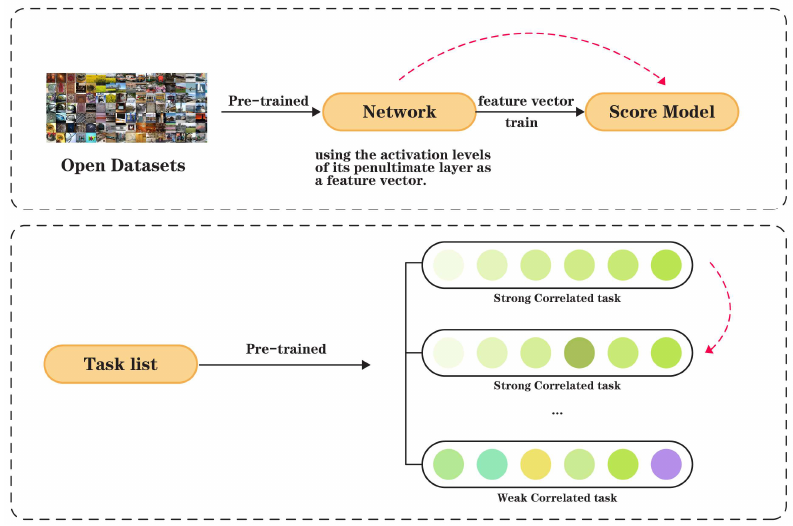
Figure 5. Visualization of transfer learning methods.